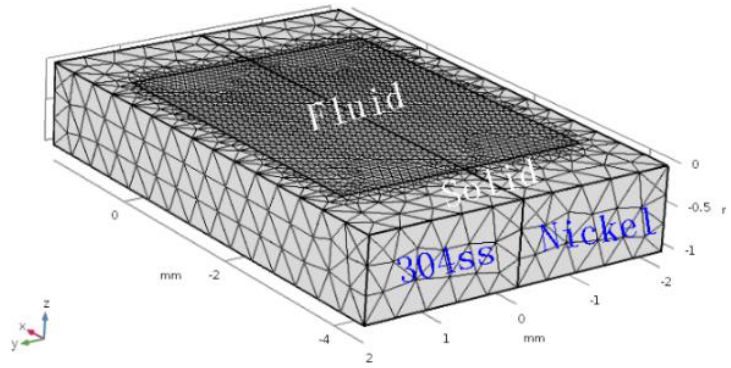
Figure 4. Model geometry and mesh grids for numerical simulation.